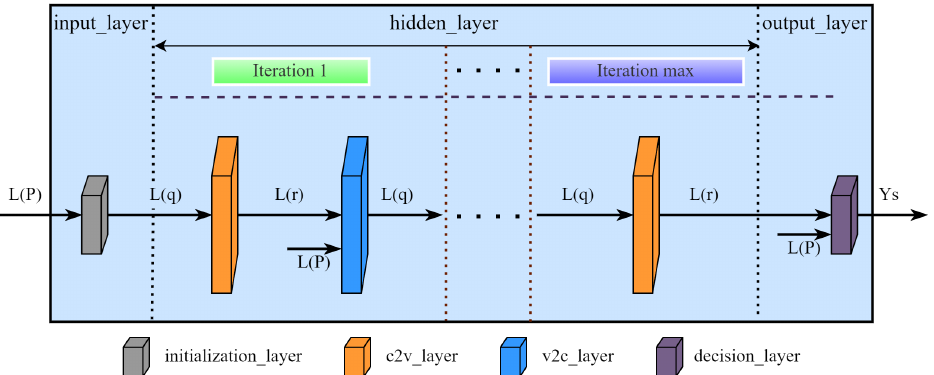
Figure 4. The proposed decoding network structure. The entire network consists of one input layer, ( 2 I − 1 ) hidden layers, and one output layer, where I is the maximum number of iterations. The input and output layers contain N neurons, corresponding to Equations (3) and (6). Iterations except the last iteration correspond to two hidden layers with E neurons, named c2v_layer and v2c_layer, respectively corresponding to Equations (4) and (5), where E is the number of non-zero elements of the check